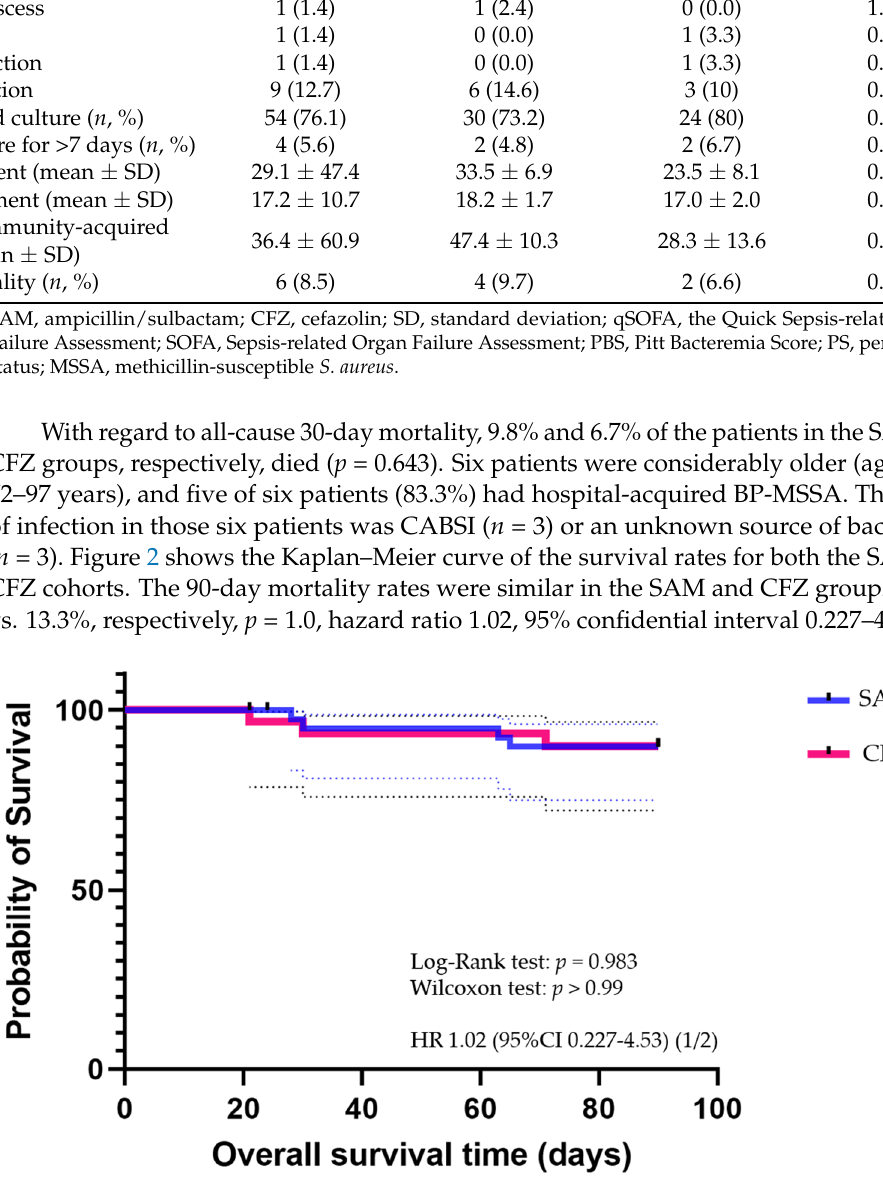
Figure 2. Kaplan–Meier survival curves of the SAM and CFZ cohort. SAM, ampicillin/sulbactam; CFZ, cefazolin; HR, hazard ratio; CI, confidence